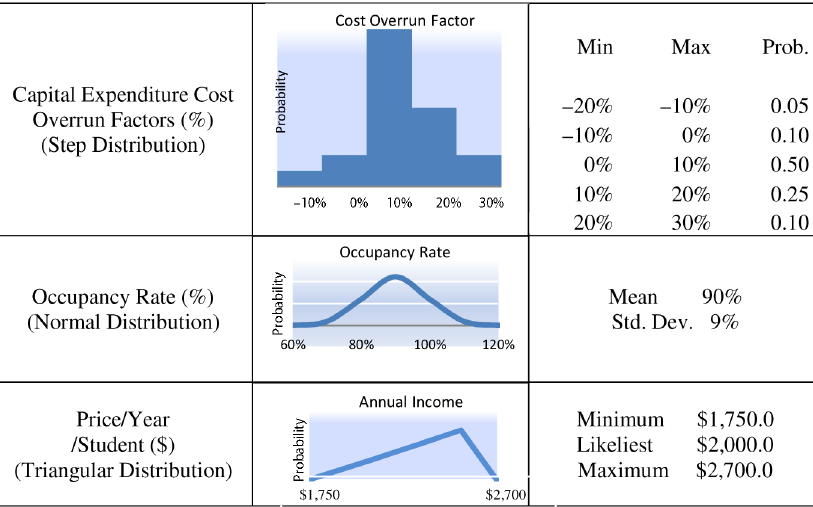
Table 2. Risk variables and probability